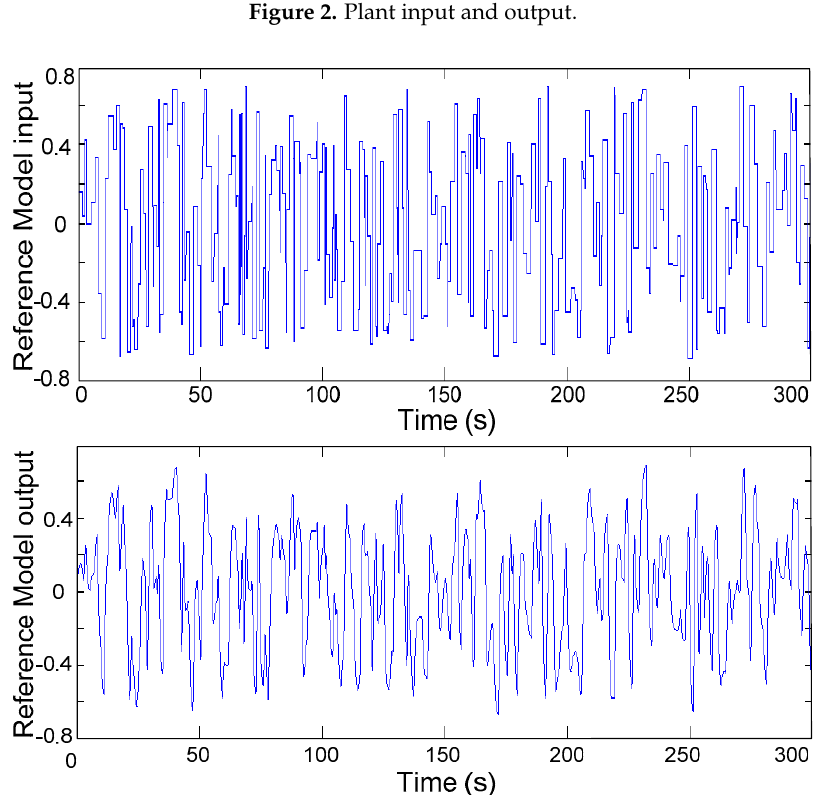
Figure 3. Reference Model input and output.